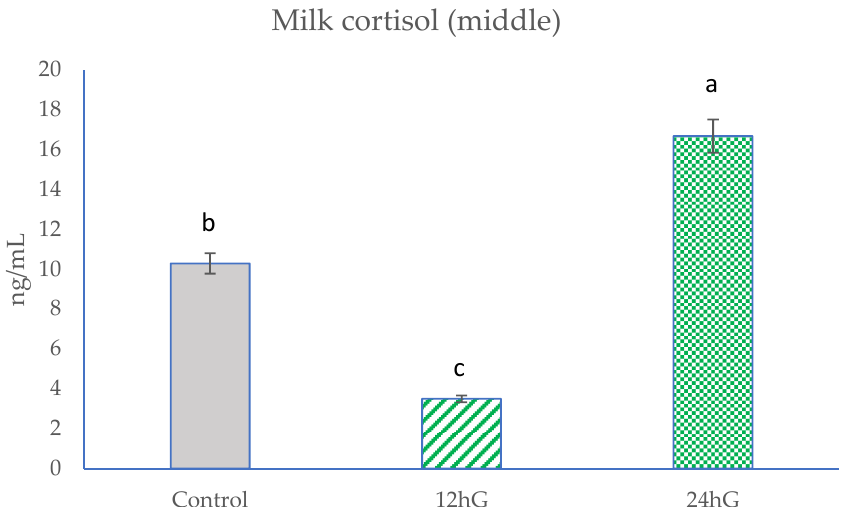
Figure 2. Milk cortisol levels at the middle of the experiment in dairy cows. Control: non-grazing group; 12 hG: 12 h grazing group; 24 hG: 24 h grazing group. Columns represented by the different letters are significantly different at p < 0.05.